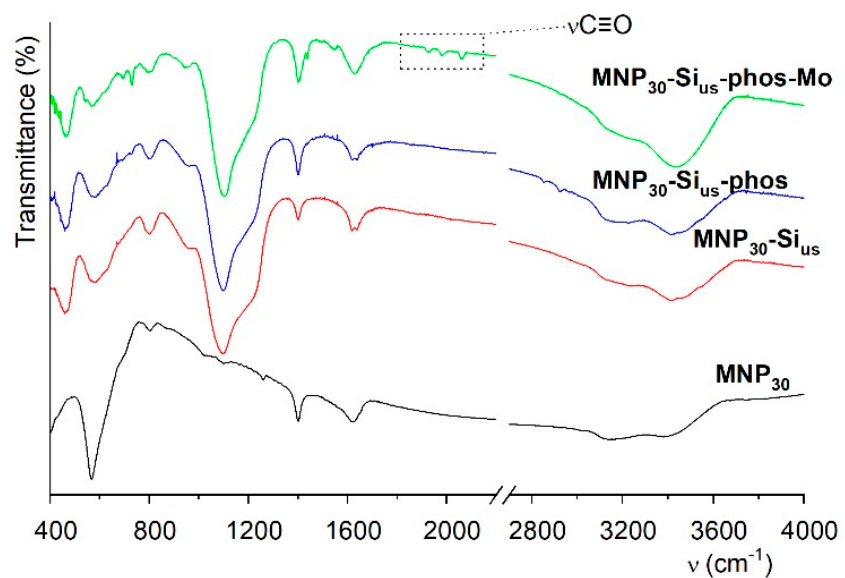
Figure 3. Fourier-transform infrared FTIR spectra of MNP 30 derived materials by ultrasonication route. The dotted box highlights the ν C ≡ O modes denoting presence of the [MoI 2 (CO) 3 ] moiety. Moreover, the spectra also showed faint bands at 2920 cm − 1 and 2852 cm − 1 ( ν C–H modes) and at 1618 cm − 1 ( ν C–O mode) and 1402 cm − 1 ( ν C=C mode) arising from the oleic acid stabilizer. The MNP 30 -Si us material, obtained after silica coating, showed an additional intense broad band appearing at 1092 cm − 1 and 1067 cm − 1 , assigned to the ν Si– O modes [26]. Upon ligand binding, MNP 30 -Si us -phos material showed additional bands